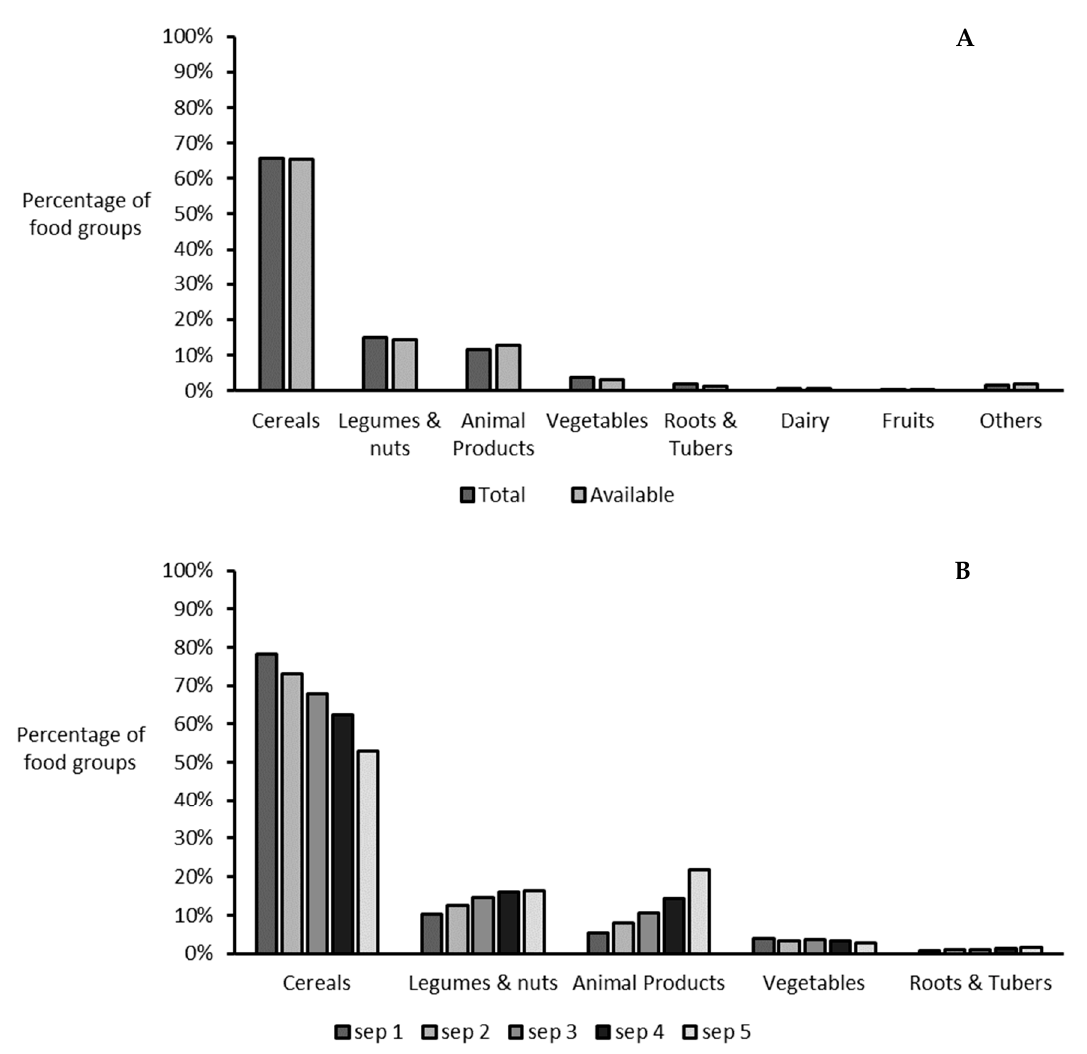
Figure 1. The food groups supplying total and available protein ( A ) and the top 5 food groups supplying total protein to the Malawian diet by household socioeconomic position ( B ). SEP: socioeconomic position (1 = poorest quintile, 5 = wealthiest quintile).